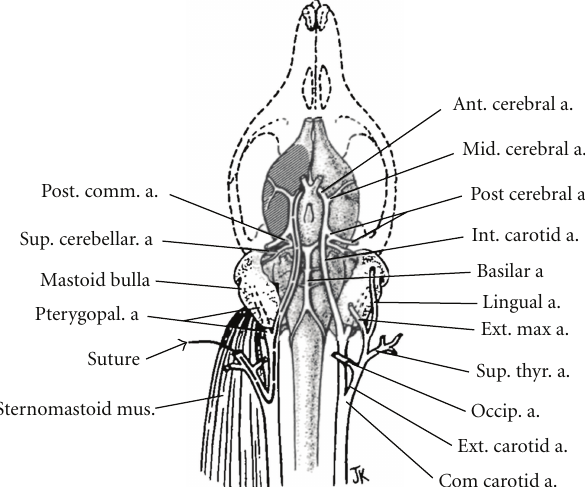
Figure 2: Diagram of cerebrovascular anatomy and MCAO in rats. Reprinted with permission from Longa, EZ et al., Stroke 1989 20: 84–91.